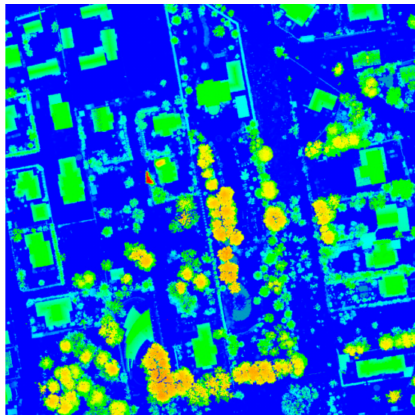
Figure 4. LiDAR data density, the selected